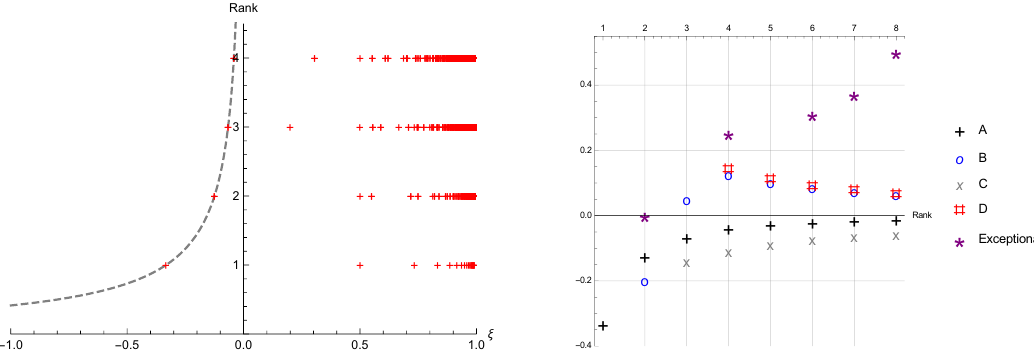
Figure 13 . Left: we show the possible values of (cid:24) in the free theories with gauge groups SU( N ). The minimal value (cid:24) = (cid:0) ( N 2 (cid:0) 1) (cid:0) 1 is plotted in a dashed curve. Right: minimal value of (cid:24) as a function of the rank for various types of gauge groups. We remind of the identities: B 2 = C 2 , A 3 = D 3 . Since A 1 =SU(2)=SP(2) and B 2 = C 2 =SP(4), the minimal value is saturated by the symplectic groups.